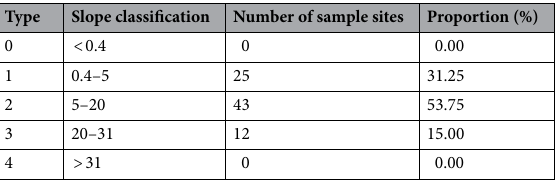
Table 4. Statistics on the number of marmot distribution sites classified by different